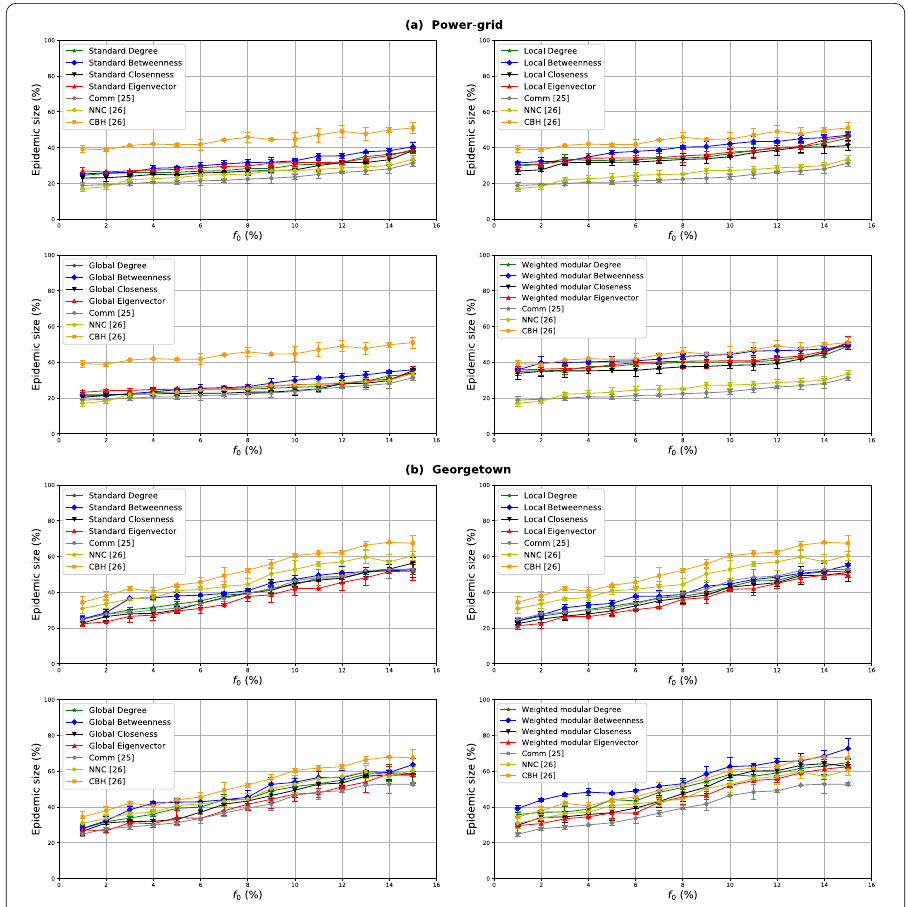
Figure 6 The epidemic size as a function of the fraction of initial spreaders f 0 . The standard and the modular variations of Degree, Betweenness, Closeness and Eigenvector centrality measures as well as some alternative measures (i.e., Comm, Number of Neighboring Communities and Community Hub-Bridge) are tested on two real-world networks of different community structure strength